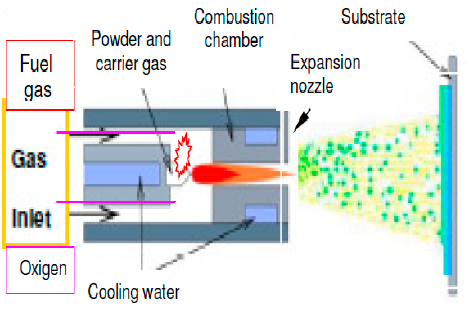
Figure 1. HVOF process schematic representation.